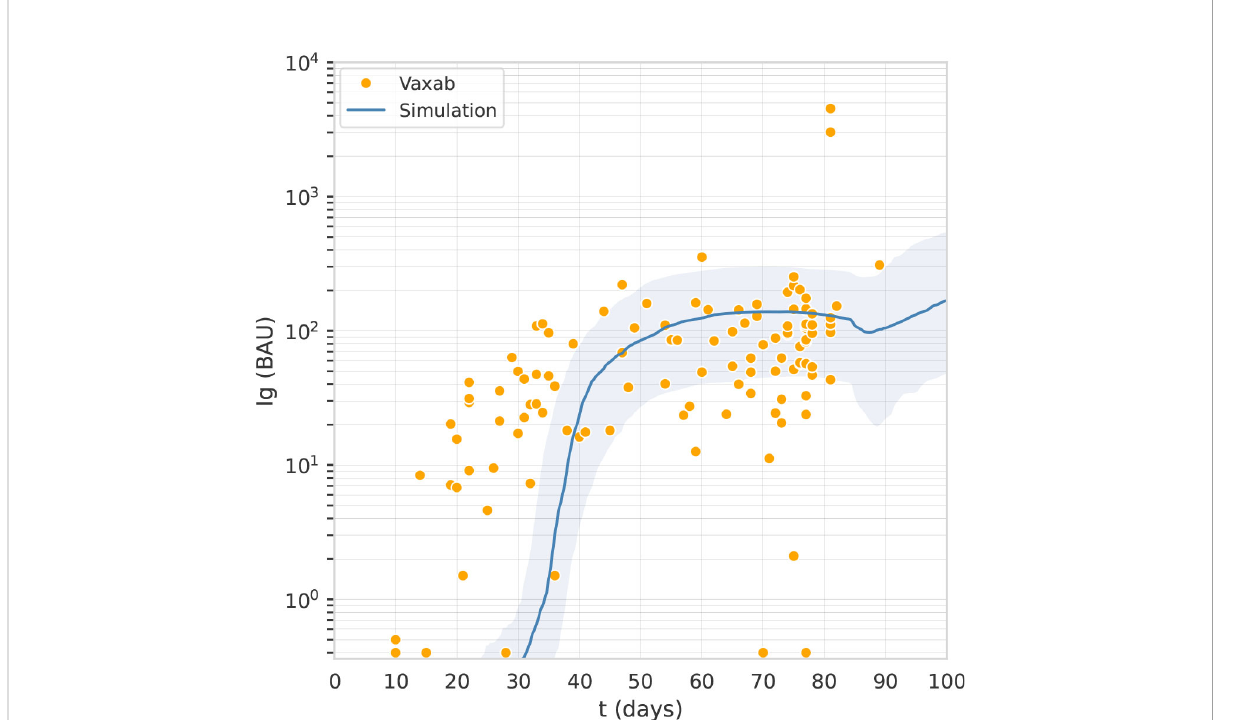
FIGURE 1 The computational model captures the antibody titer trajectory, characterized by a plateau. Overlay of a line graph representing in-silico Ig levels after the fi rst dose (the line represents the median, the shading represents the IQR) with a dot plot representing RBD-Spike Ig BAU in individuals who have received one dose of AstraZeneca, in the Vaxab